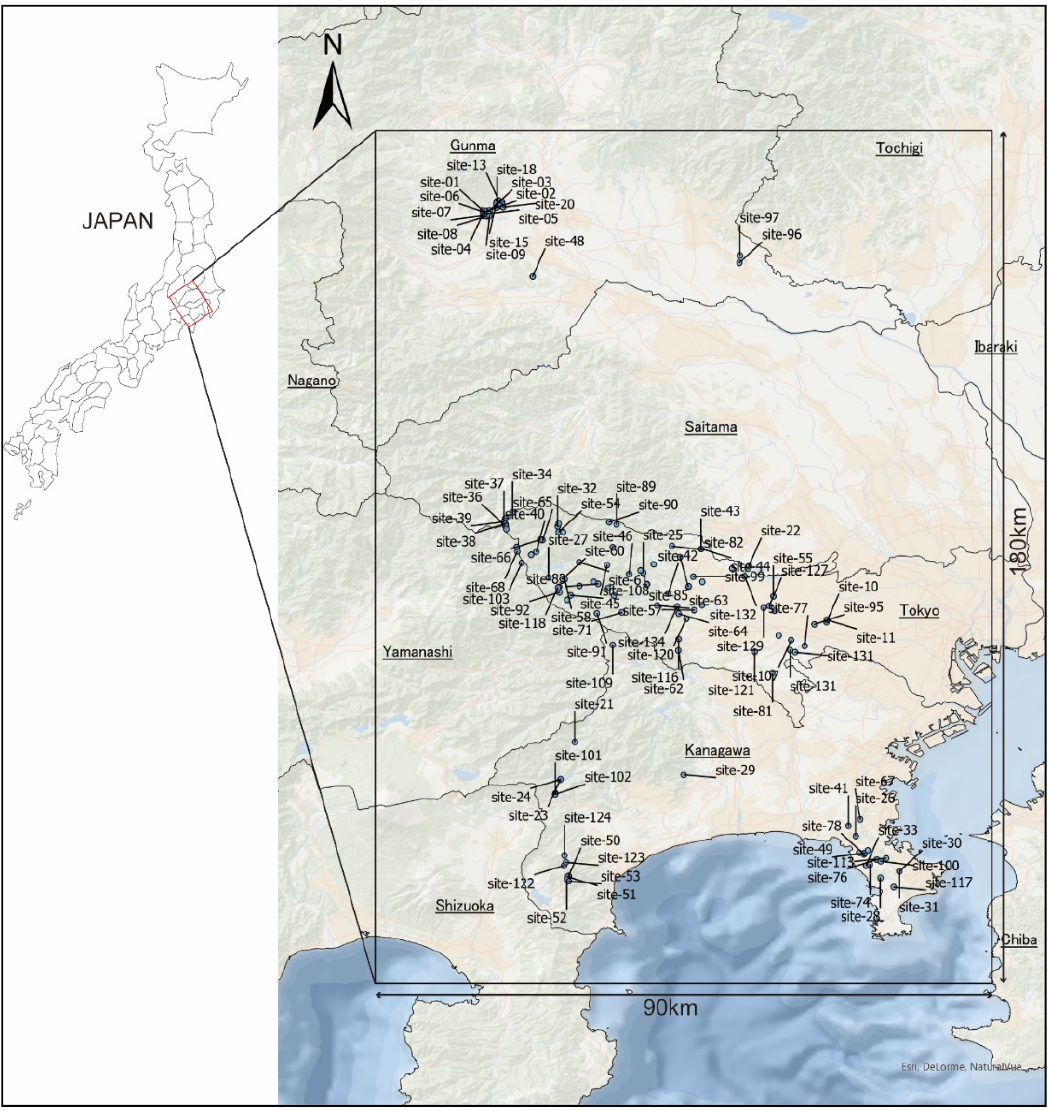
Figure 1. Study area (90 km × 180 km). The blue dots indicate tick survey sites (The basemap image is provided by Esri, Inc.).